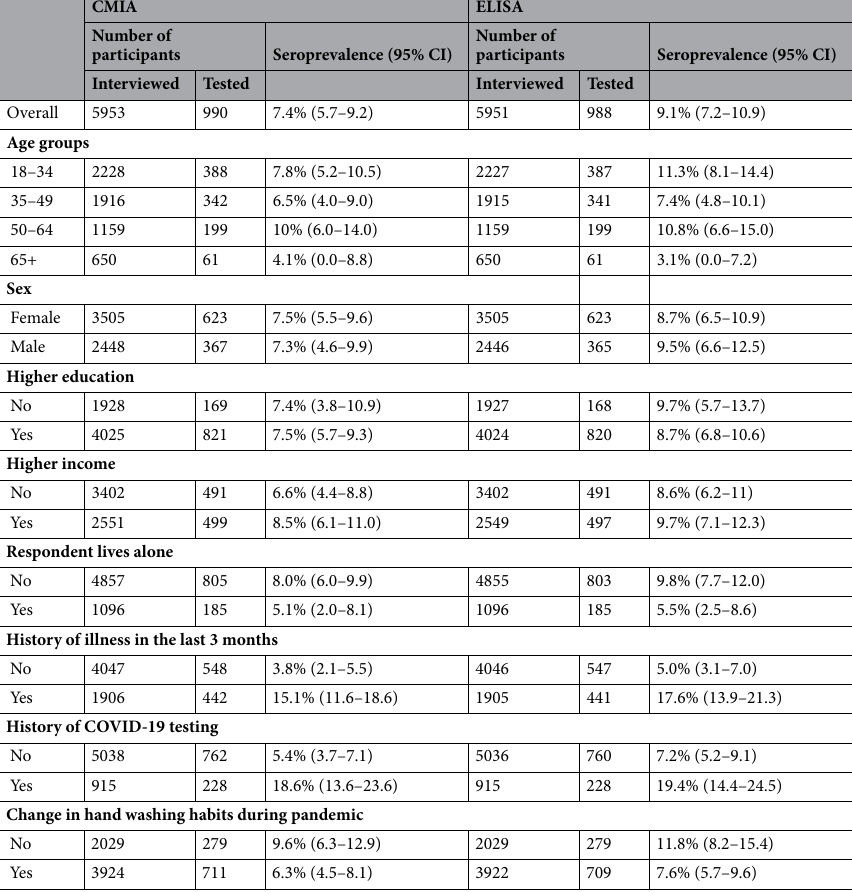
Table 2. Seroprevalence of SARS-CoV-2 in subgroups of participants. All estimates are from the model that includes demographics, socioeconomic status and characteristics associated with seropositivity. All estimates are corrected for test sensitivity and specificity (see Statistical appendix for details).